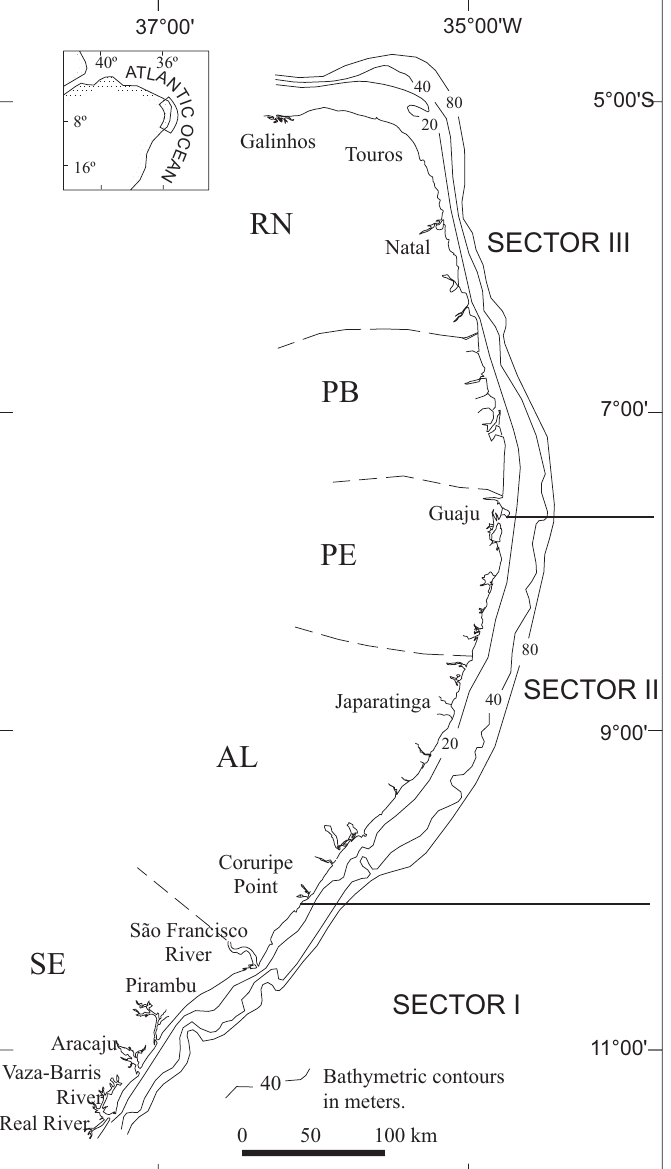
Fig. 1 – Physiographic features of the continental shelf of the Brazilian northeast region between Galinhos and Real river. Also shown the location of the different sectors discussed in the text. The following states are depicted in the figure: SE – Sergipe,